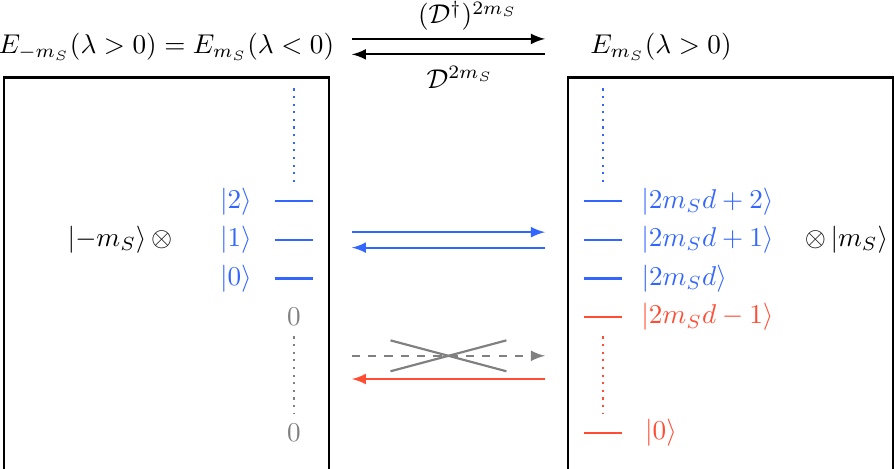
† ) 2 m S and 2 m S between the two subspaces E Figure 7: Sketch of the mappings ( − m D D S d and E . Reversing λ amounts to reverse m . The branch m at λ > 0 has 2 m m S S S S d extra modes that do not have a paring partner for λ < 0. There are therefore 2 m S modes in the branch m for λ > 0 compared to λ < 0 (in red). All the other number S states can be paired with a number state of the space E − , or equivalently E with m S m S λ <